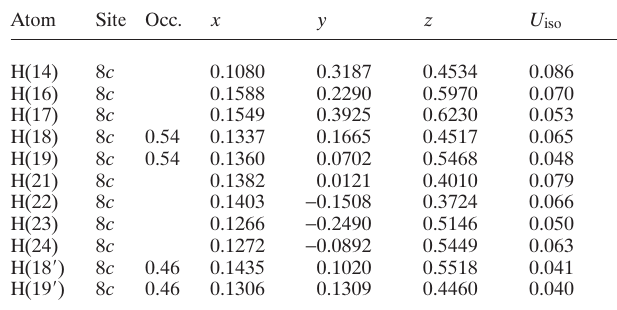
Table 2. Atomic coordinates and displacement parameters (in Å 2 ) . Atom Site